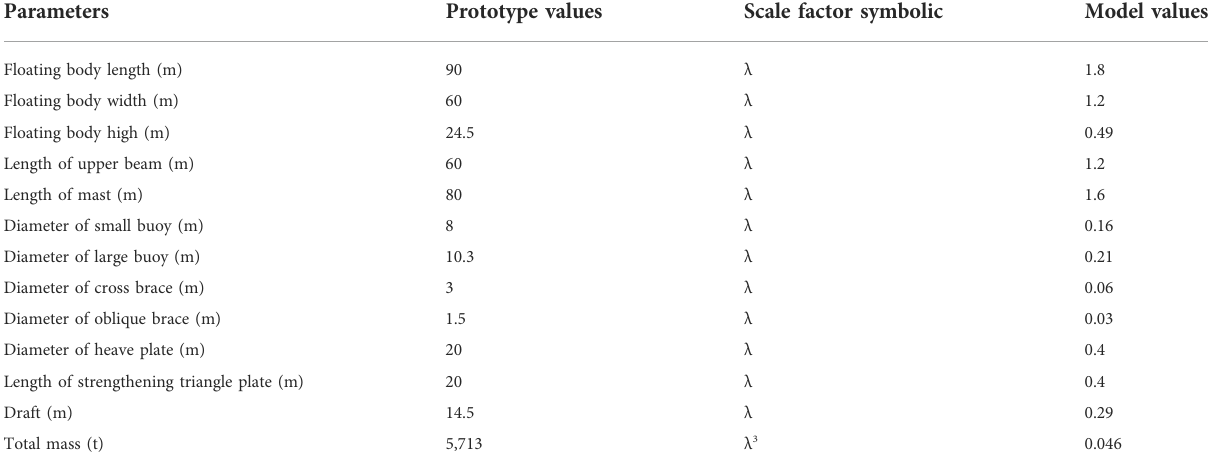
TABLE 3 Parameters of the fl oating offshore wind